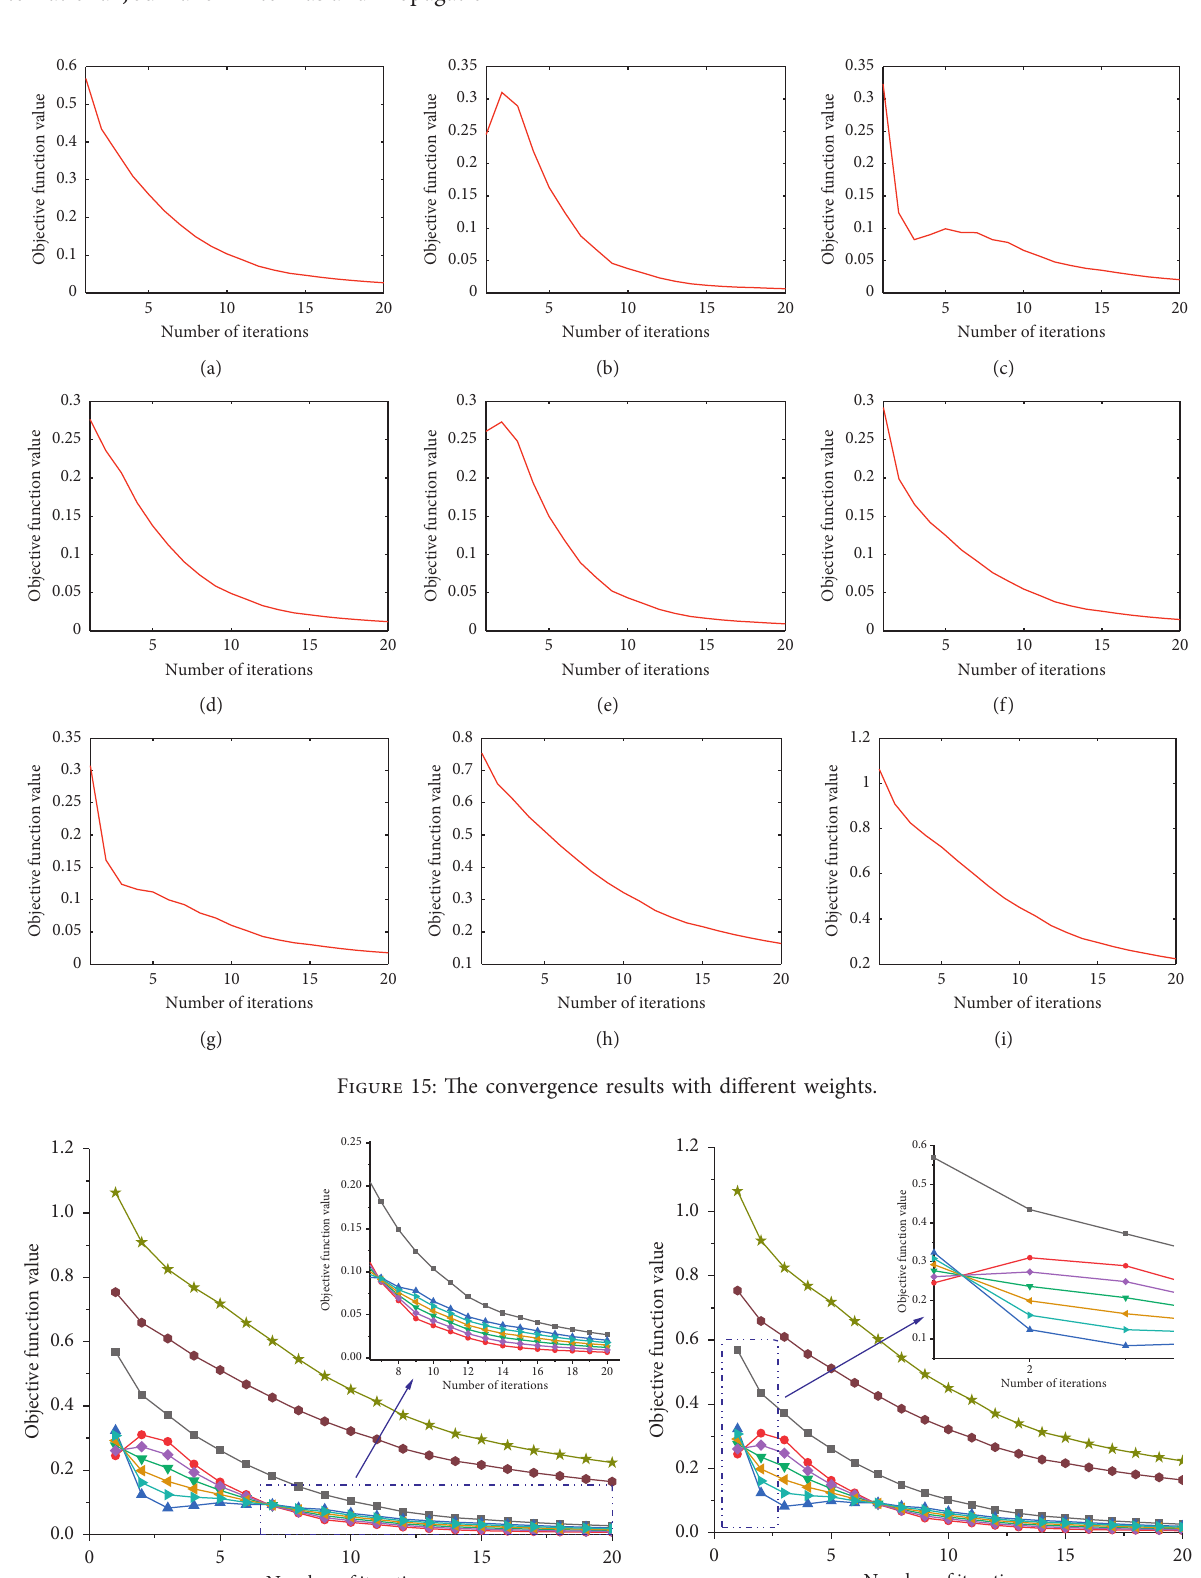
Figure 16: The convergence results of CSI with fixed weights for the regular